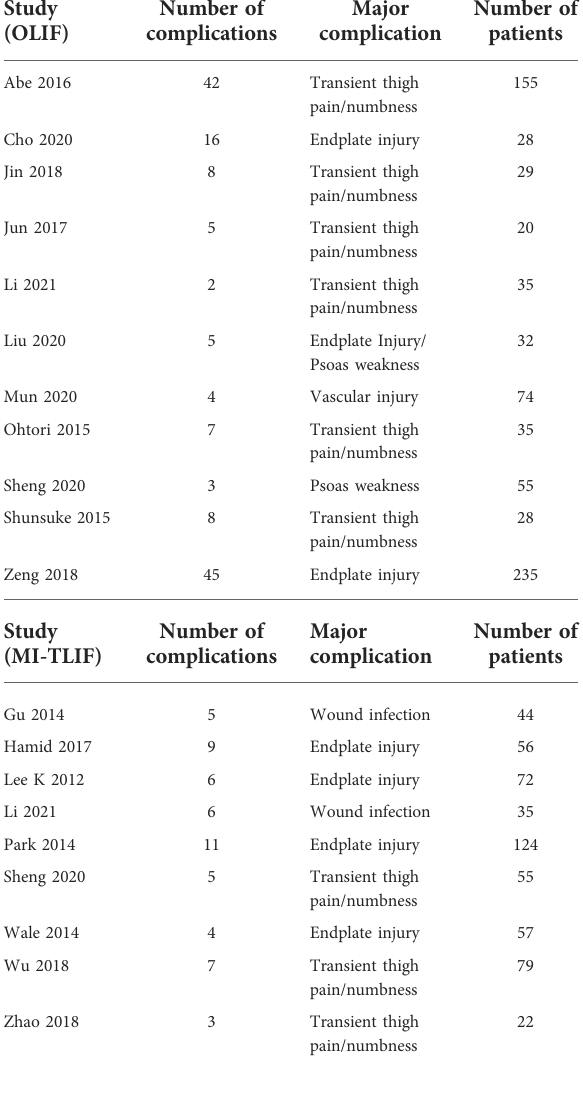
TABLE 4 Complications of OLIF and MI-TLIF studies.